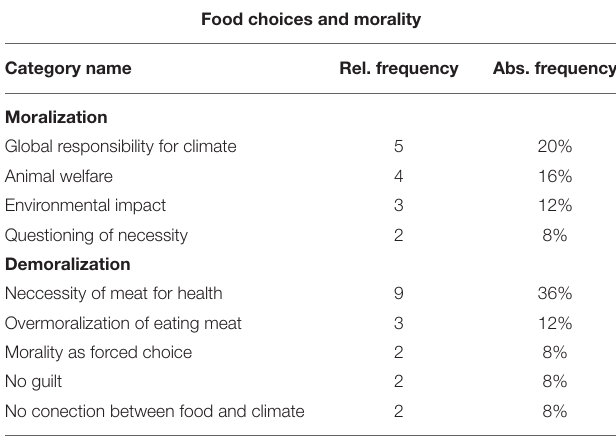
TABLE 5 | Role of morality in food choices found in 25 guideline-based interviews (inductive category system; categories with single occurrence are not mentioned in the category